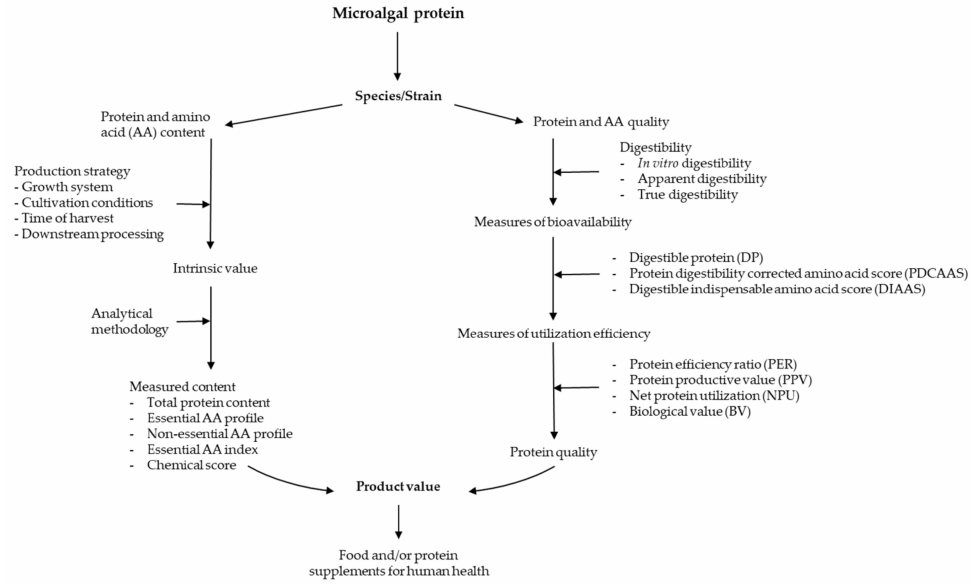
Figure 1. Factors affecting microalgal protein content and quality and common assessment